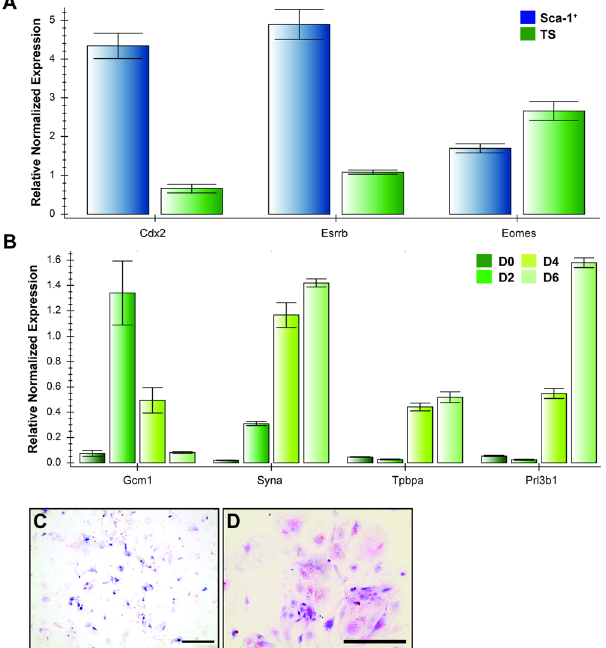
Figure 4. TS cell markers, Cdx2 and Esrrb were more highly expressed in Sca-1 + trophoblast isolated from differentiated TS cell cultures than in non-sorted, proliferating TS cell cultures ( A ). Sca-1 + trophoblast isolated from differentiated TS cultures gave rise to proliferating trophoblast cell lines that when differentiated by the removal of growth factors, expressed genes indicative of syncytiotrophoblast ( Gcm1, Syna ), spongiotrophoblast ( Tpbpa ) and TGCs ( Prl3b1 ) ( B ). These differentiated cells were also positive for alkaline phosphatase activity ( C , blue) and PAS ( D , magenta/arrowhead) indicating differentiation of sinusoidal TGCs and glycogen trophoblast, respectively. D0 represents undifferentiated, proliferating TS cells while, D2, D4, D6 represent cultures differentiated for 2, 4 or 6 days. In C, scale bar = 500 um. In D, scale bar = 100